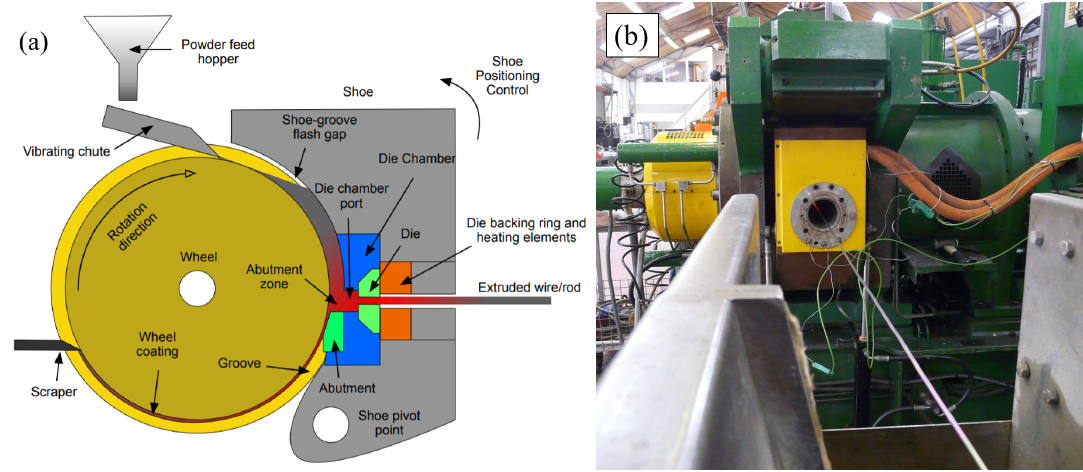
Figure 7. ( a ) Schematic representation of the Conform TM process. ( b ) Example of low oxygen, ductile, titanium alloy wire produced direct from powder